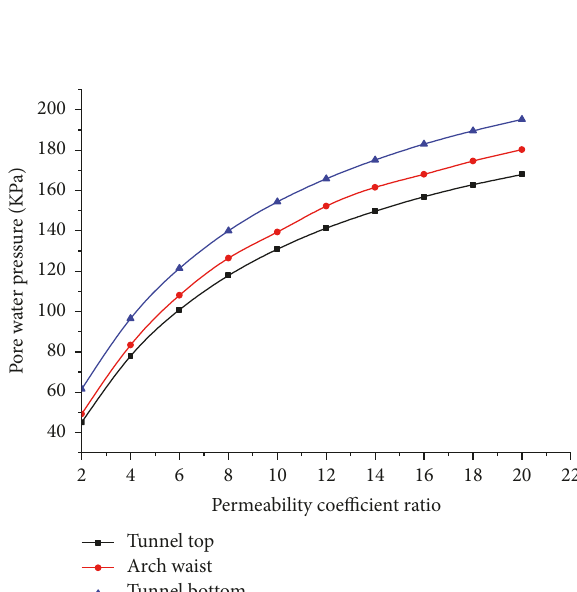
Figure 12: Flow velocity curve.